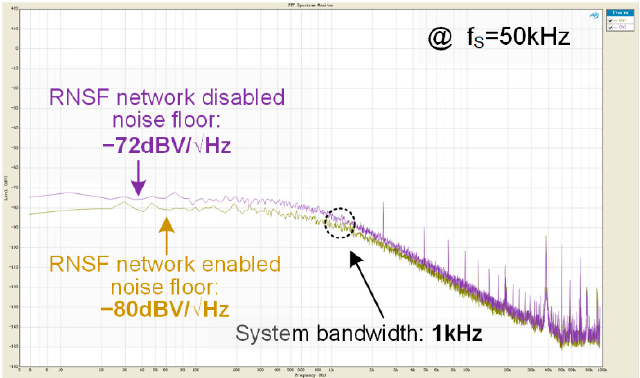
Figure 17. Measurement results of the output PSD of readout circuit with the RNSF technique and without the RNSF technique. Table 3. Comparison of readout circuit for open-loop MEMS capacitive sensor.